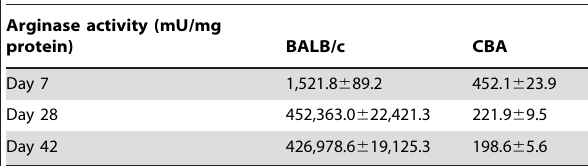
Groups of BALB/c and CBA (n=4) mice were infected with metacyclic L. major parasites in one hind footpad and 1, 4 and 6 weeks post infection, individual footpads were harvested and arginase activity was determined by enzymatic assay. Values given are the average arginase activity 6 standard deviation. Data show the results of one representative experiment out of three independent